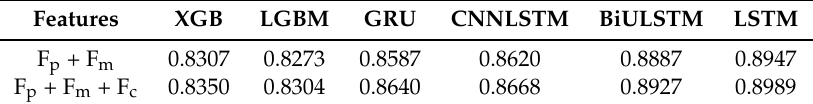
Table 3. Models’ average R values with/without CMAQ features.